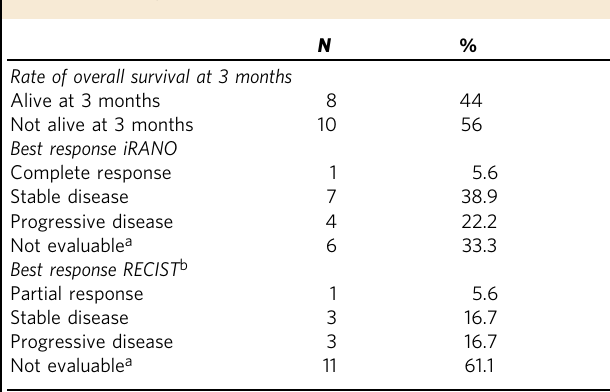
Table 2 Patient demographics: other therapy. Table 3 Ef fi